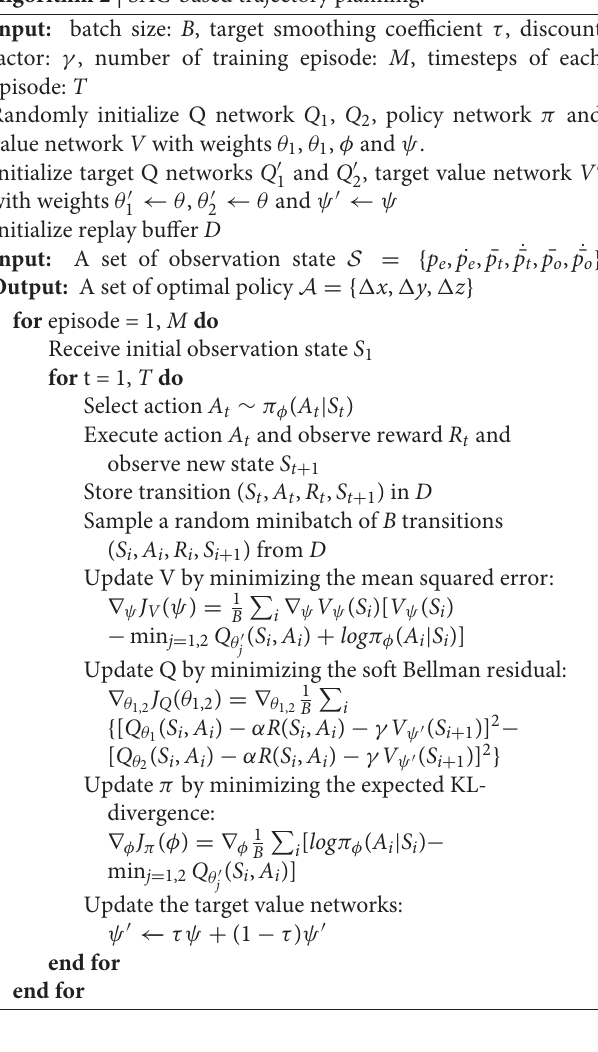
Algorithm 2 | SAC-based trajectory